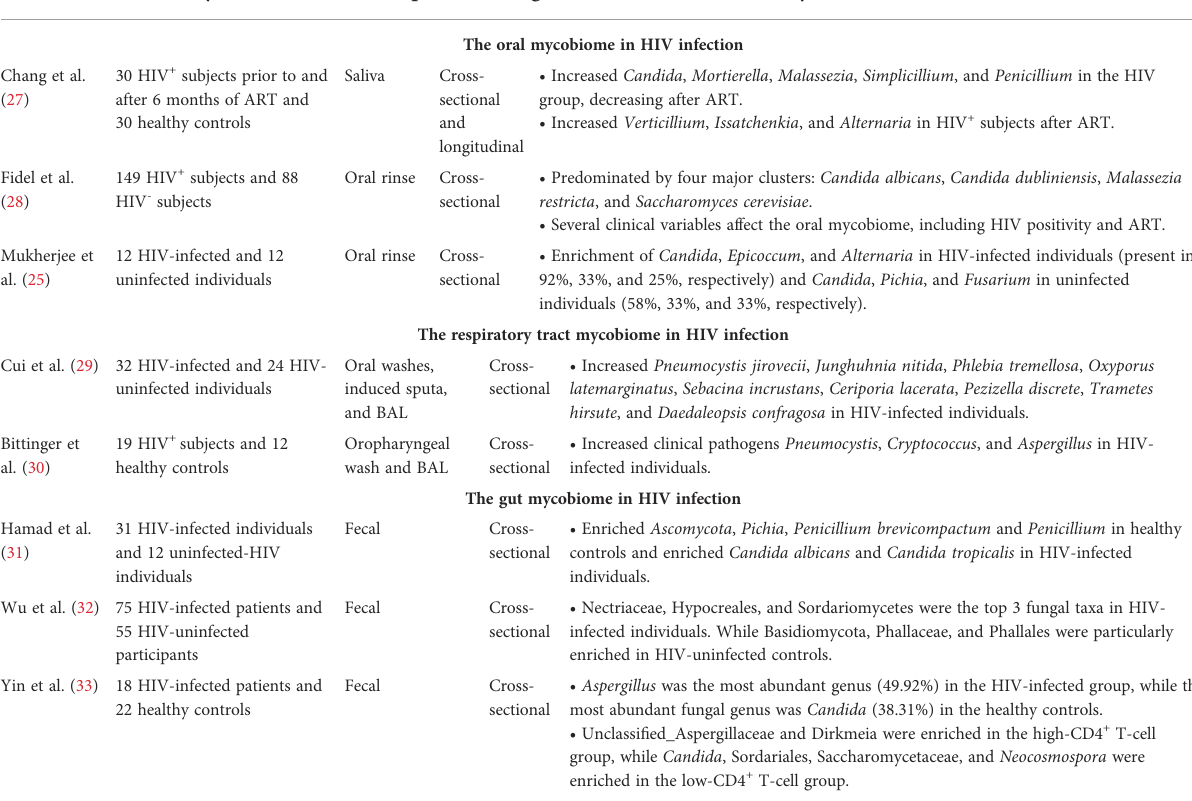
TABLE 1 The mycobiome in HIV